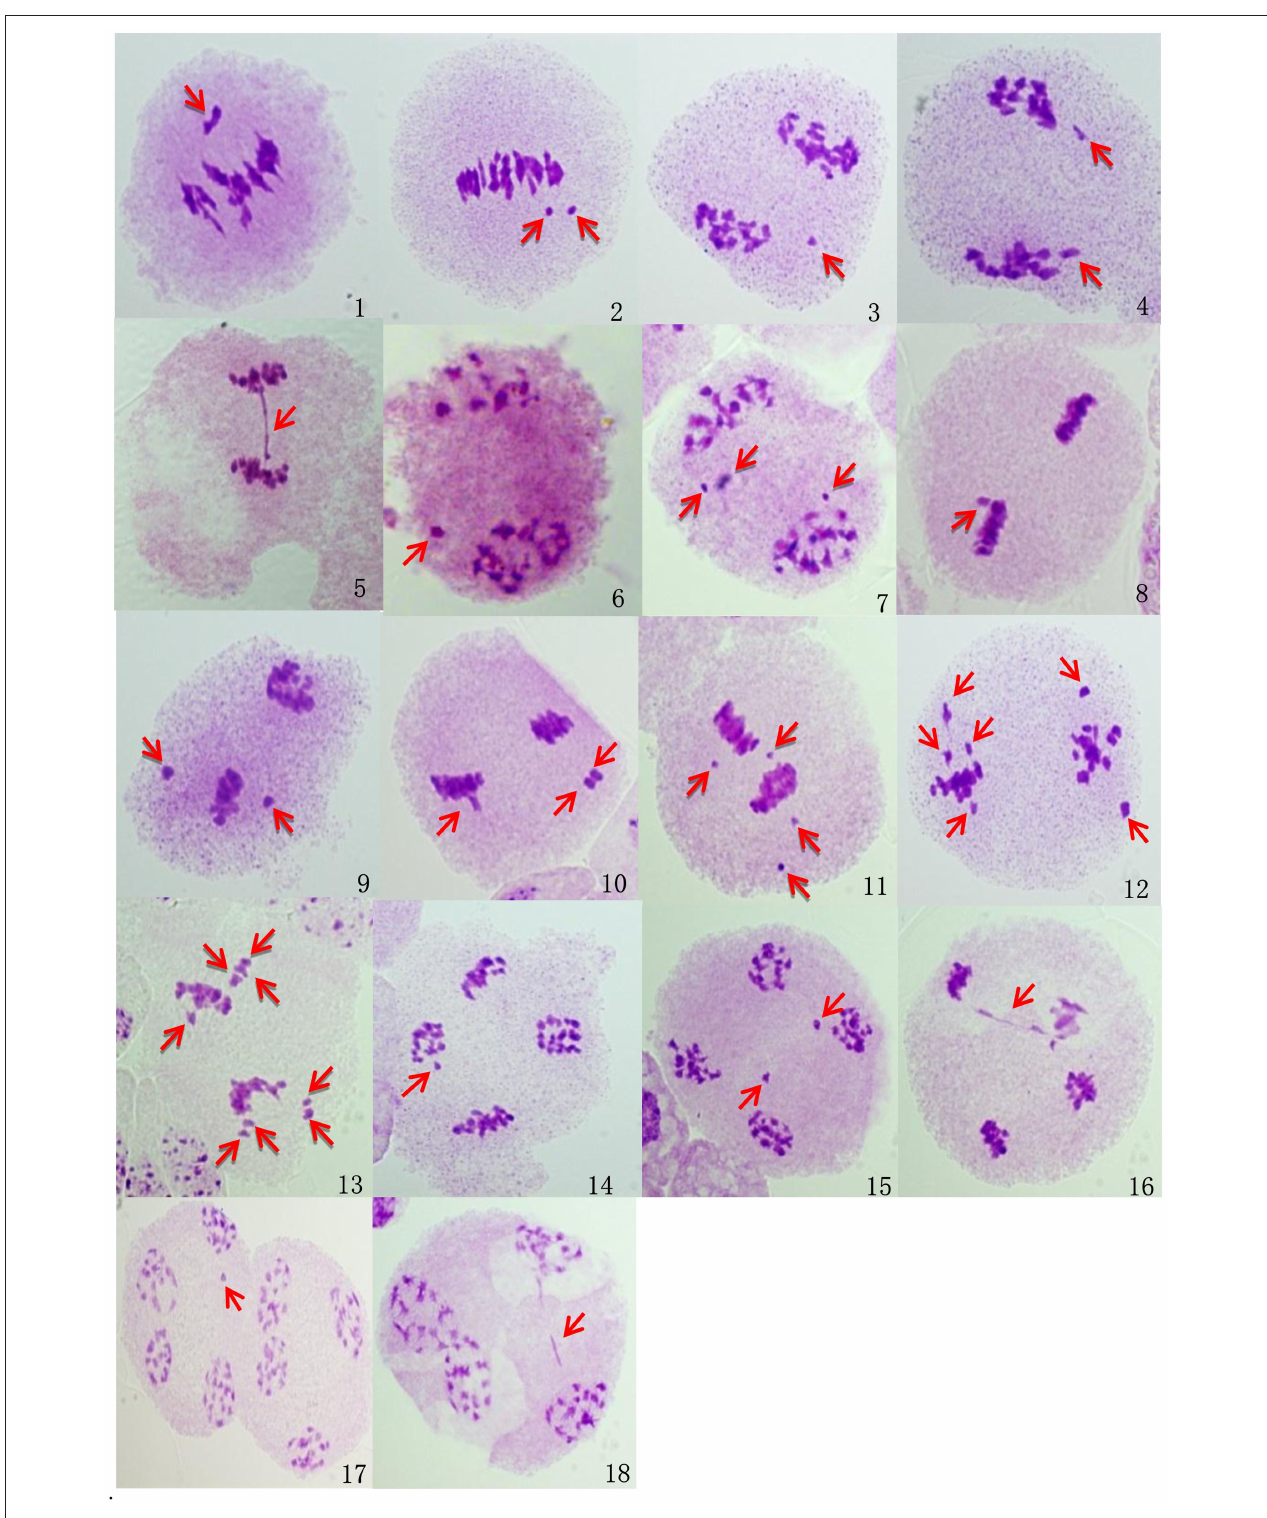
FIGURE 7 | Microscopic observations of the abnormal meiosis of pollen mother cells in BC1mF4R. Images were taken using a light microscope (ZEISS, imager. M2, 100 × ). (1-2). Metaphase I: 1. One lagging chromosome; (2). two lagging chromosomes. (3-5). Anaphase I: 3. one lagging chromosome; 4. two lagging chromosomes; 5. one chromatid bridge. (6-7). Telophase I: 6. one micronucleus; (7). three micronuclei. (8-13). Metaphase II: (8). one lagging chromosome; (9). two lagging chromosomes; (10). three lagging chromosomes; (11). four lagging chromosomes; (12). six lagging chromosomes; (13). eight lagging